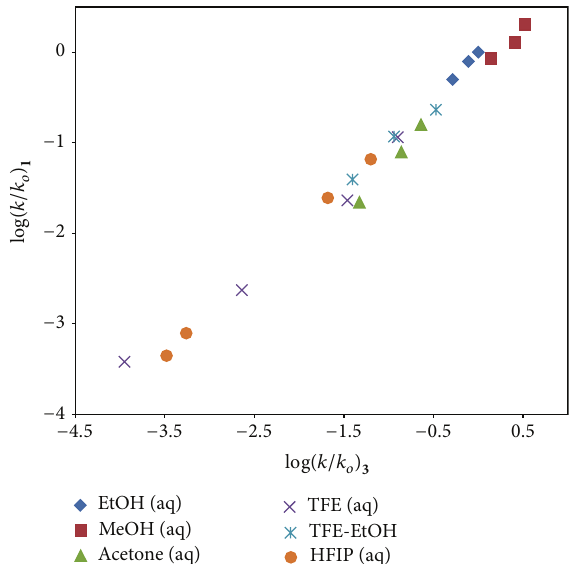
Figure 2: The plot of log (𝑘/𝑘 𝑜 ) for 4,5-dimethoxy-2-nitrobenzyl chloroformate ( 1 ) at 25.0 ∘ C against log (𝑘/𝑘 𝑜 ) for phenyl chlorofor- mate ( 3 ) at 25.0 ∘ C in the twenty common pure and binary solvents